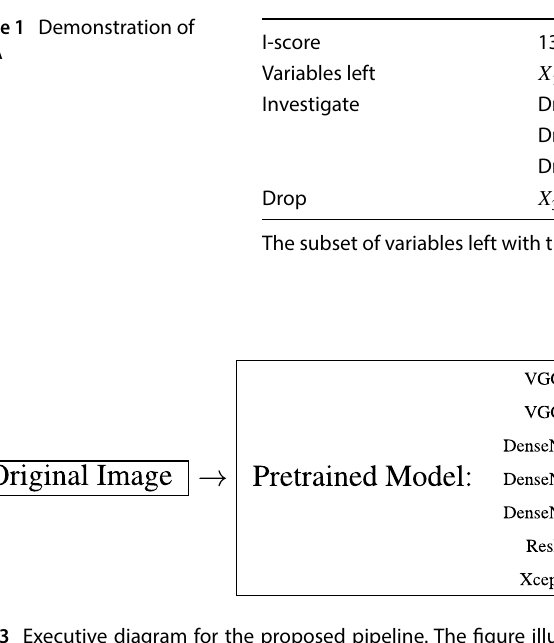
Fig. 3 Executive diagram for the proposed pipeline. The figure illustrates the major steps of the proposed pipeline. In the following flow- chart, the proposed algorithm starts with the training sample of the original image data. Training samples are fed into pretrained mod- els such as VGG16/19, DenseNet121/169/201, ResNet, and Xception. Features of any layer of the above pre-trained CNNs can be extracted. From practice, it is often recommended to extract the last convolutional layer of a pre-trained CNN to be new features. The proposed I-score can then be applied to examine the explainability of each features by computing I-score directly. Alternatively, BDA can be applied and groups of features can be selected. Each group form a higher-order interaction and we call this group a variable module. Individual feature and groups of features can then be used to form classifier by feeding them into a feed-forward neural network. Because the features are finely selected, the feed-forward neural network requires very much less number of parameters then its peers to achieve similar or